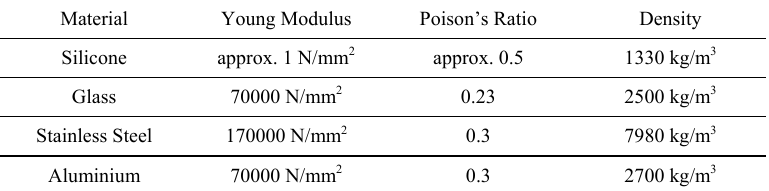
Table 1: Representative material properties.